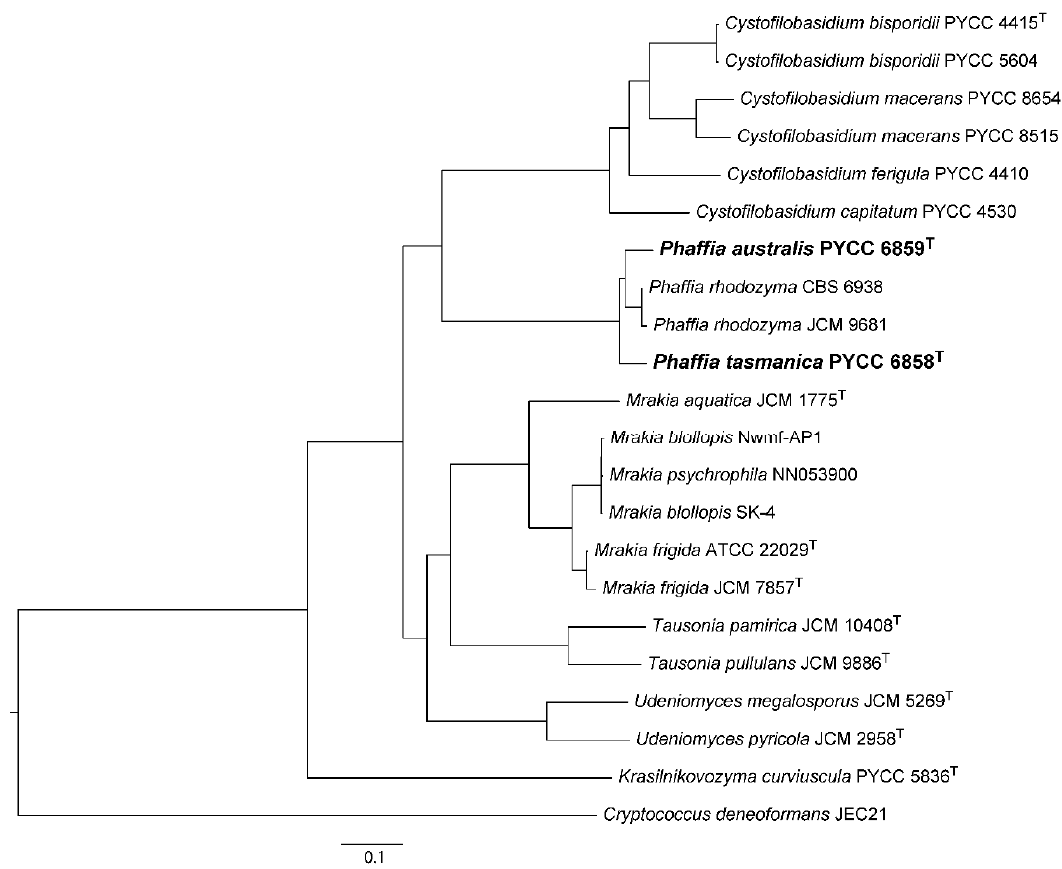
Figure 1. Genome-based phylogenetic placement of Phaffia australis and P. tasmanica within the Cystofilobasidiales. The phylogeny was inferred from a concatenated alignment of 485 amino acid sequences corresponding to single copy core genes from all taxa (including Cryptococcus deneoformans employed to root the tree) , using the LG+F+I+G4 model of sequence evolution and the maximum likelihood method as implemented in IQ-TREE. The analysis includes representative species of six genera of the Cystofilobasidiales ( C., Cystofilobasidium, K., Krasilnikovozyma, M., Mrakia, P., Phaffia, T., Tausonia, and U., Udeniomyces ) with the two new Phaffia species depicted in bold. All branches have 100% bootstrap support (fast bootstrap with NNI optimization), and branch lengths correspond to the expected number of substitutions per site. Draft genome sequences of representatives of Cystofilobasidium and Phaffia were also used to estimate alignment-free pairwise distances (Figure 2). Low divergence values (Kr) of less than 0.07 were obtained for comparisons involving three genomes of P. rhodozyma , whereas congeneric